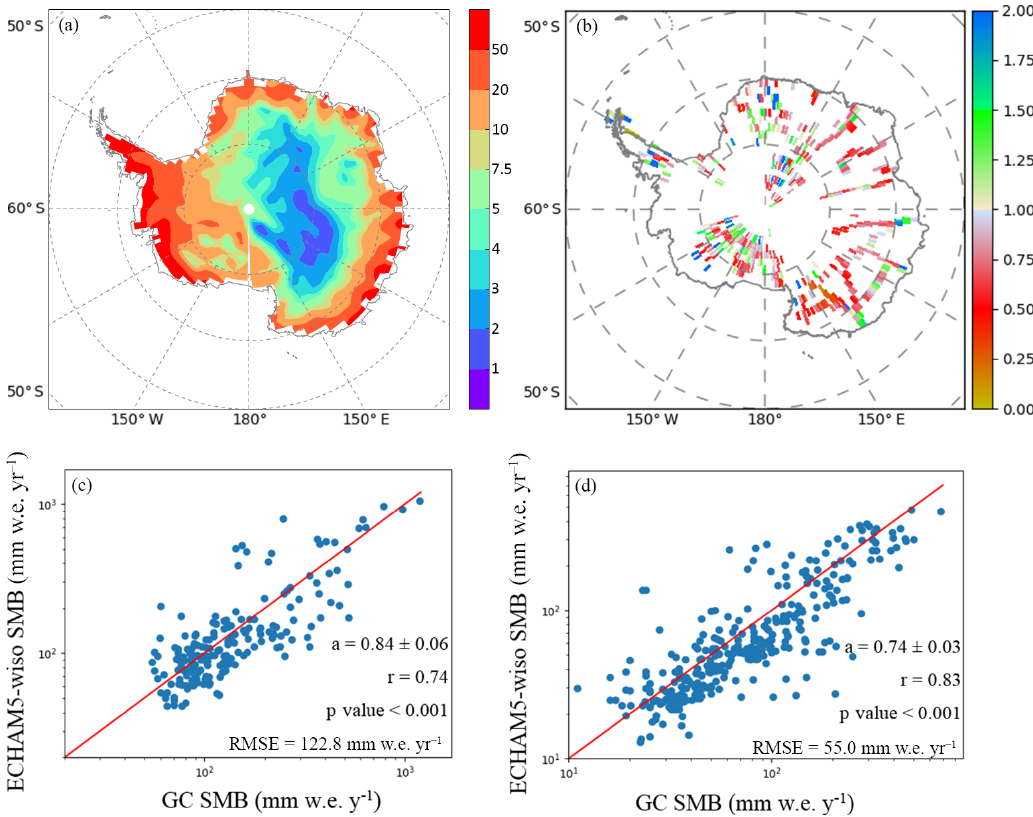
Figure 4. Comparison of the GLACIOCLIM (hereafter and noted in the plots as “GC”) SMB database averaged within the ECHAM5- wiso grid cells and the SMB (i.e. precipitation–evaporation) simulated by the model, with the spatial distribution of the accumulation (a) as simulated by the model (in cmw.e.yr − 1 ), (b) the ratio of the ECHAM5-wiso annual accumulation (precipitation minus evaporation) to the GC averaged SMB (no unit), and GC-averaged SMB values against SMB values simulated by the model (blue dots) associated with the corresponding linear relationships (red solid line); displayed at the logarithm scale for elevation ranges of 0–2200ma.s.l. (with the upper limit excluded) (c) and 2200–4000ma.s.l. (d)